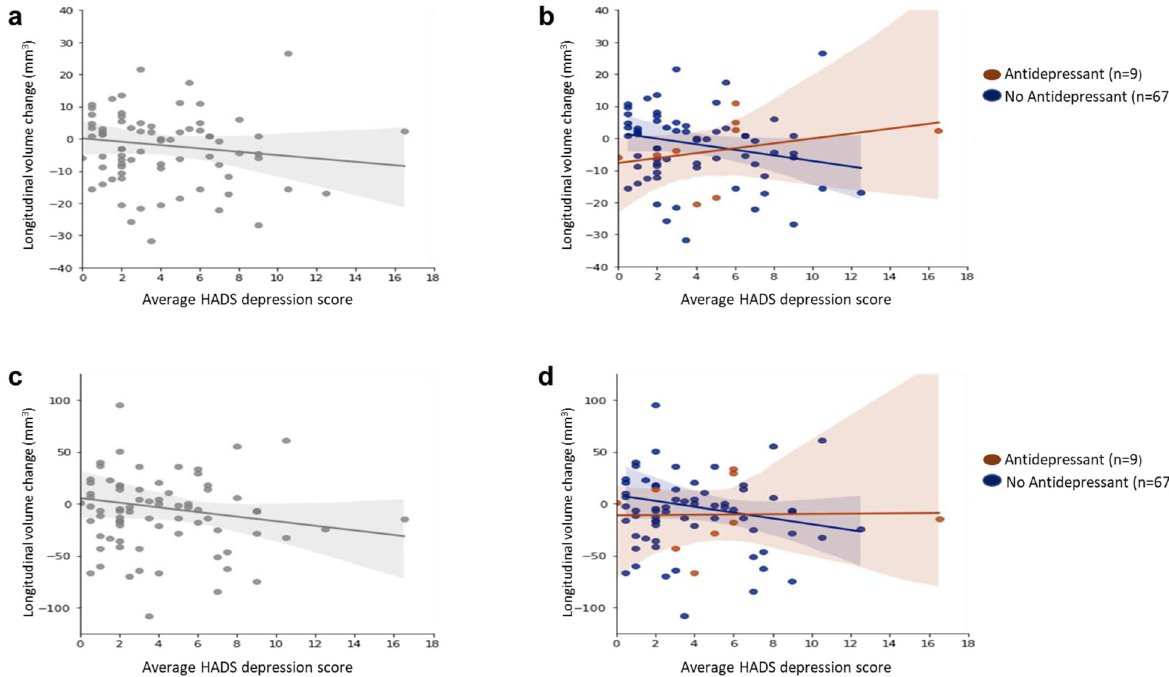
Fig. 1 Relationship between HADS depression score and longitudinal change in pulvinar anterior and pulvinar medial volumes. The top panels show scatter plots for longitudinal change in pulvinar anterior (PuA) volume in relation to average HADS depression score for all PD participants ( a ) and also separately for PD participants taking (brown) or not taking (blue) antidepressants ( b ). The corresponding scatter plots for pulvinar medial (PuM) volume change in relation to average HADS depression is shown in the bottom panels for all PD participants ( c ) and separately for participants taking (brown) or not taking (blue) antidepressants ( d ). Overall, higher HADS depression scores were associated with volume decreases in the right PuA ( r = − 0.12, P = 0.30) ( a ) and right PuM ( r = − 0.12, P = 0.28) ( c ). However, when participants were separated into those taking or not taking antidepressants, there was a positive correlation between HADS depression scores and longitudinal volume change in the right PuA for those taking antidepressants ( r = 0.34, P = 0.37) but a negative correlation for those not taking antidepressants ( r = − 0.18, P = 0.14) ( b ). There was a similar pattern for the right PuM; Antidepressant group ( r = 0.02, P = 0.96); No antidepressant group ( r = − 0.14, P = 0.26) ( d